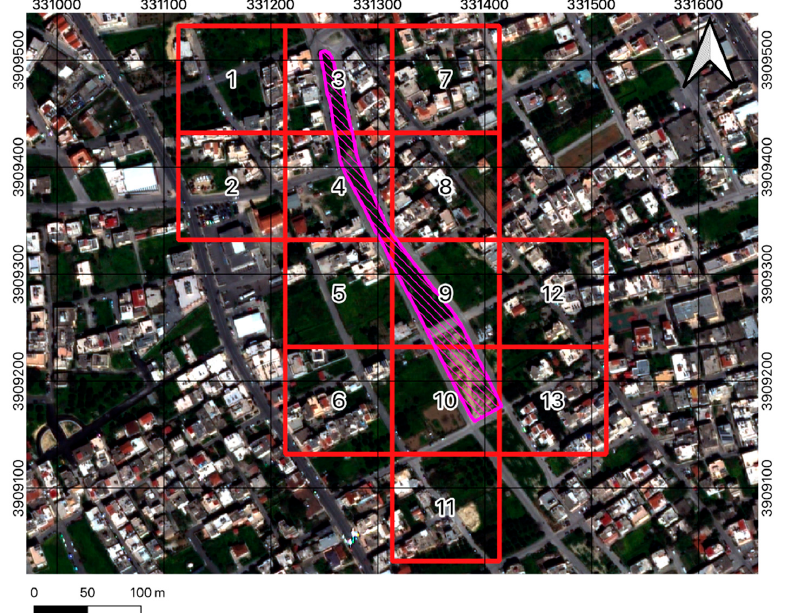
Figure 6. The grid that was used to run SUEWS over the study area, consisting of 100 m × 100 m cells, numbered from 1 to 13. The area is residential, and the major Local Climate Zone (LCZ) type is LCZ6 [46] corresponding to Open Low-Rise based on the classification scheme proposed by Steward and Oke [47]. Numerous patches of land of no particular use exist, which are mostly cov- ered by low vegetation or bare soil.